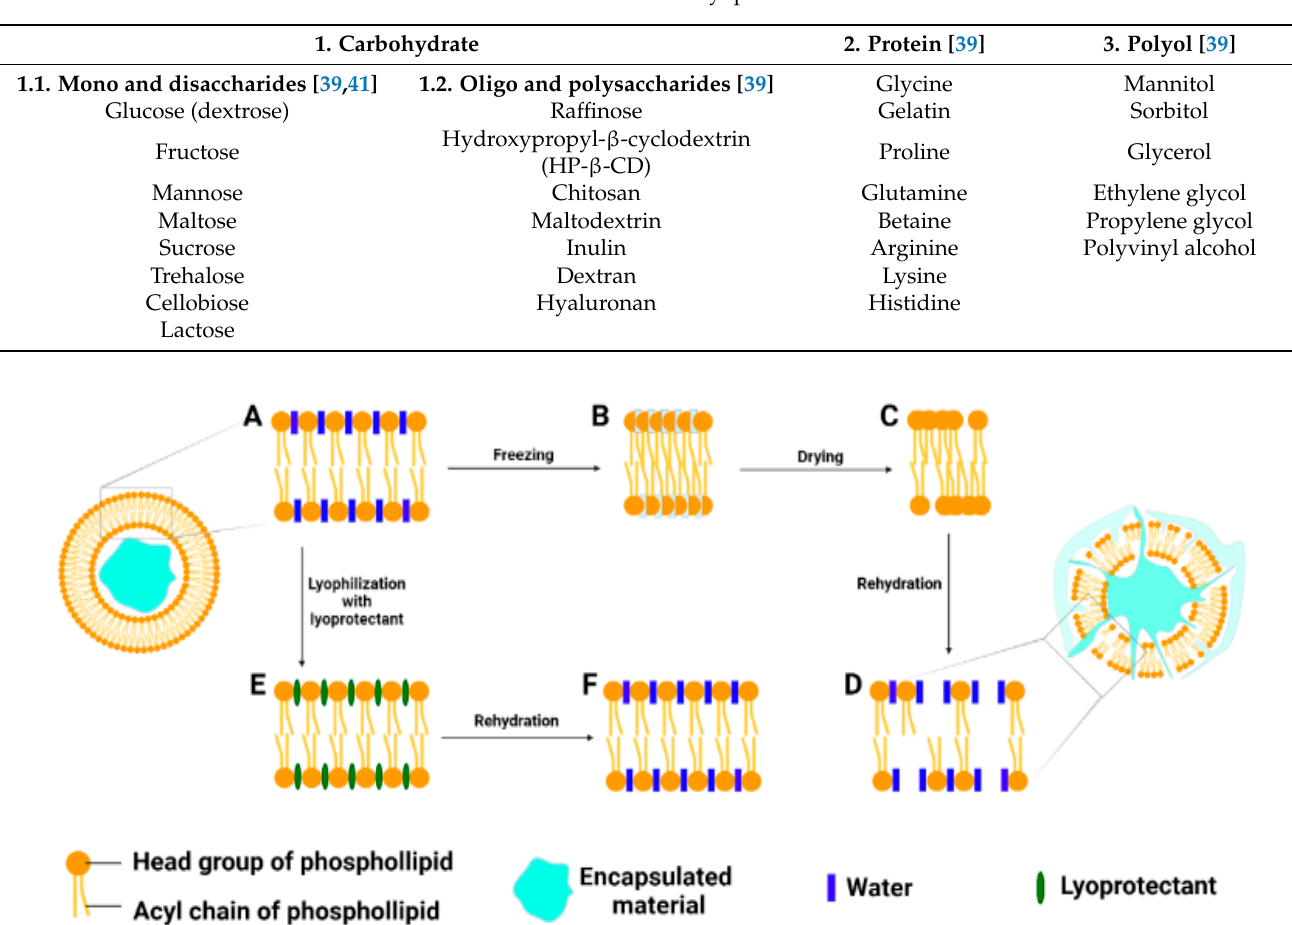
Figure 3. Mechanism of water replacement during lyophilization and rehydration. Adapted from [42], Elsevier,